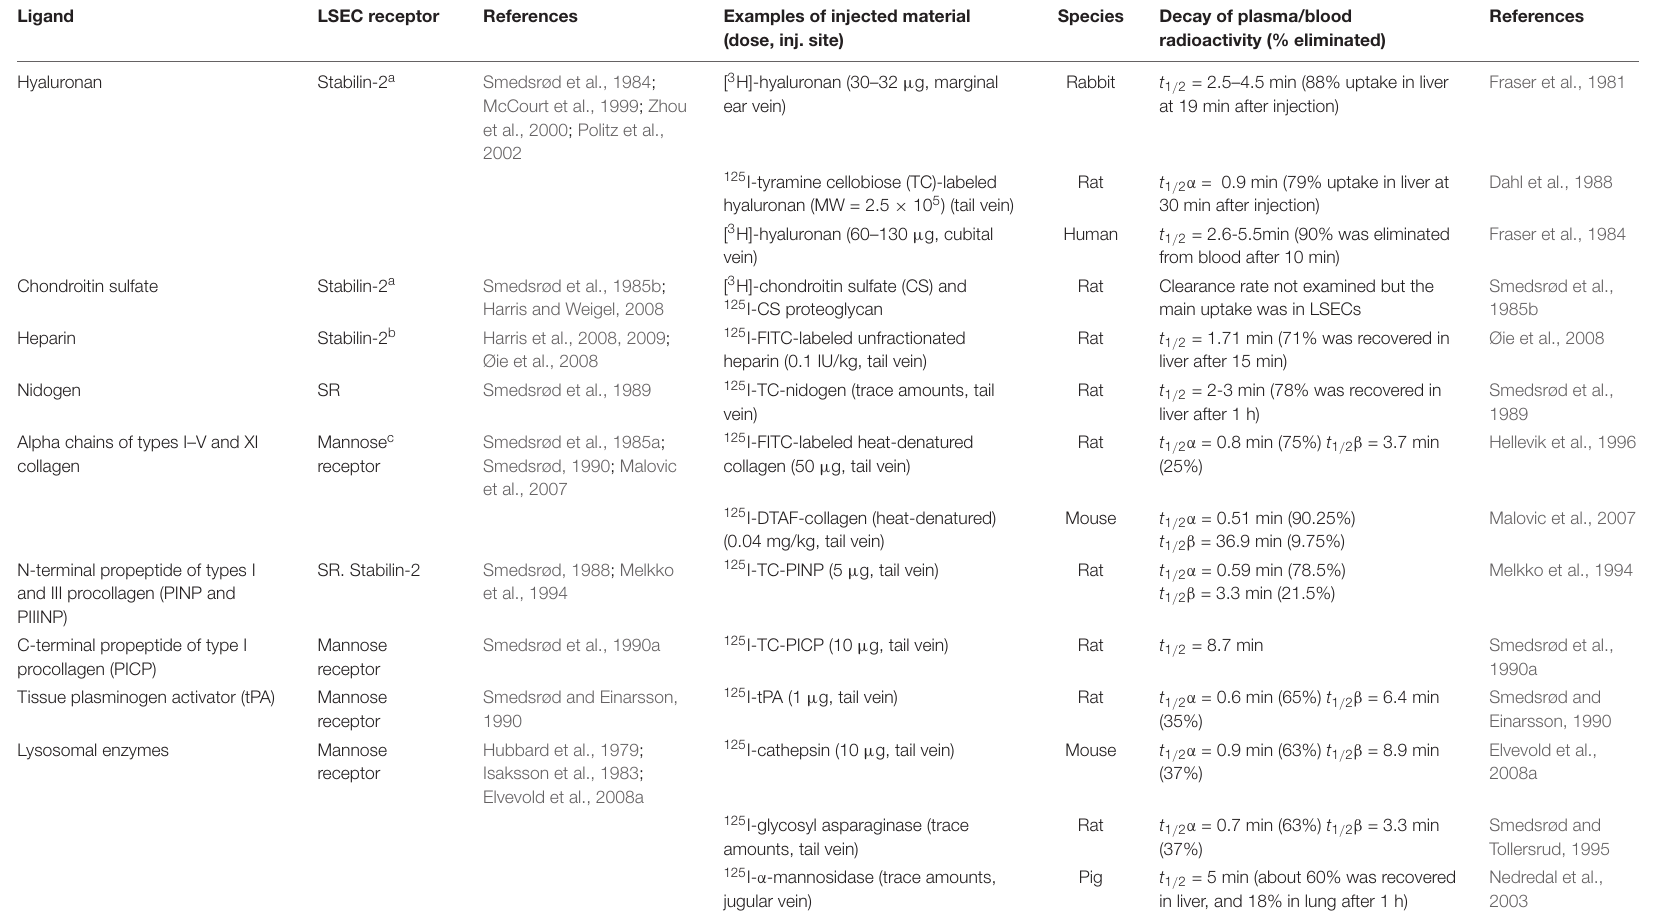
TABLE 1 | Tissue turnover products cleared from blood mainly by LSECs*, the endocytosis receptor involved in the LSEC uptake, examples of rate of blood clearance of ligands taken up by LSECs following i.v. administration of the ligand, and species